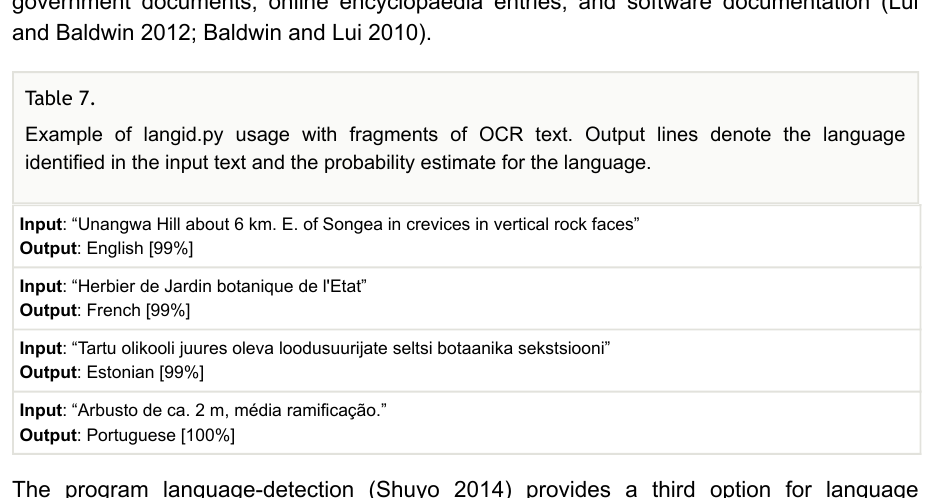
government documents, online encyclopaedia entries, and software documentation (Lui and Baldwin 2012; Baldwin and Lui 2010).